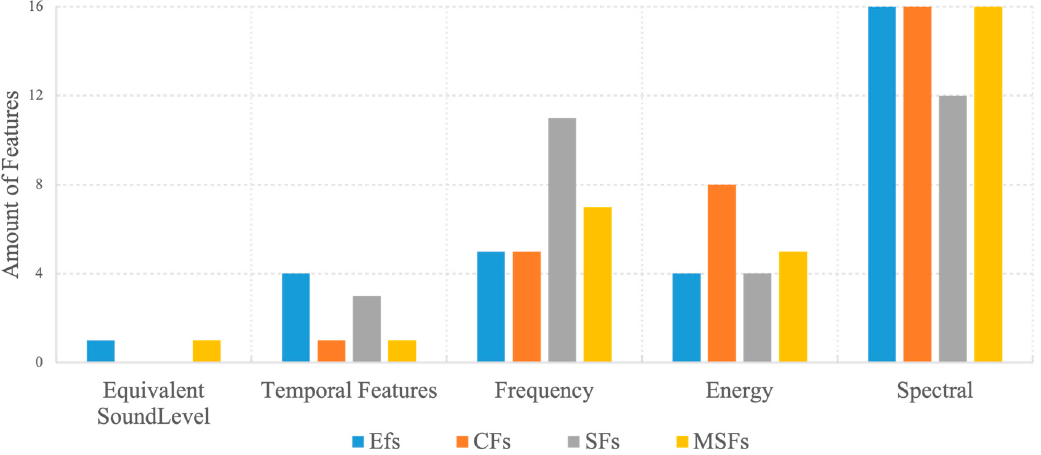
Figure 8. The comparison of the top 30 features in EFs, CFs, SFs, and MSFs.